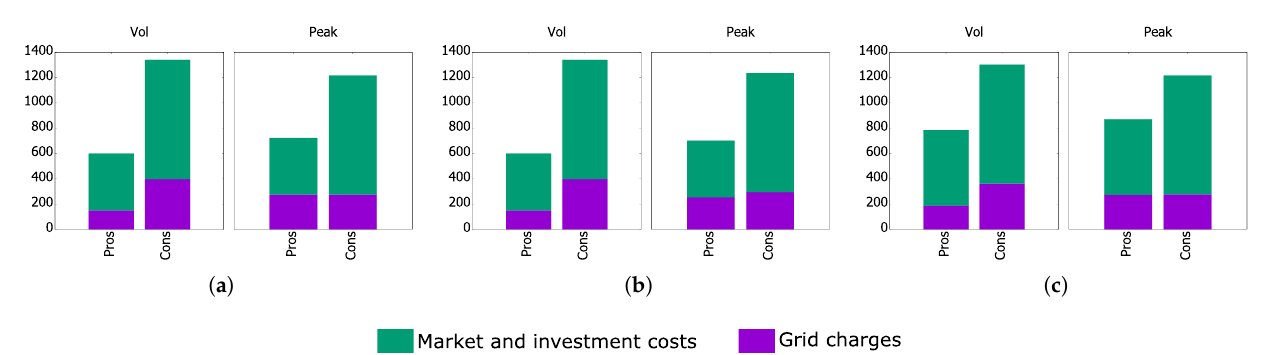
Figure 11. FCOEs for prosuming and consuming households [EUR/a] for different battery operation modes (1/2/3), network cost allocation schemes (vol/peak), and 50% prosumer penetration ratio under consideration of widespread e-mobility. ( a ) Battery mode 1 with e-mobility; ( b ) Battery mode 2 with e-mobility; ( c ) Battery mode 3 with